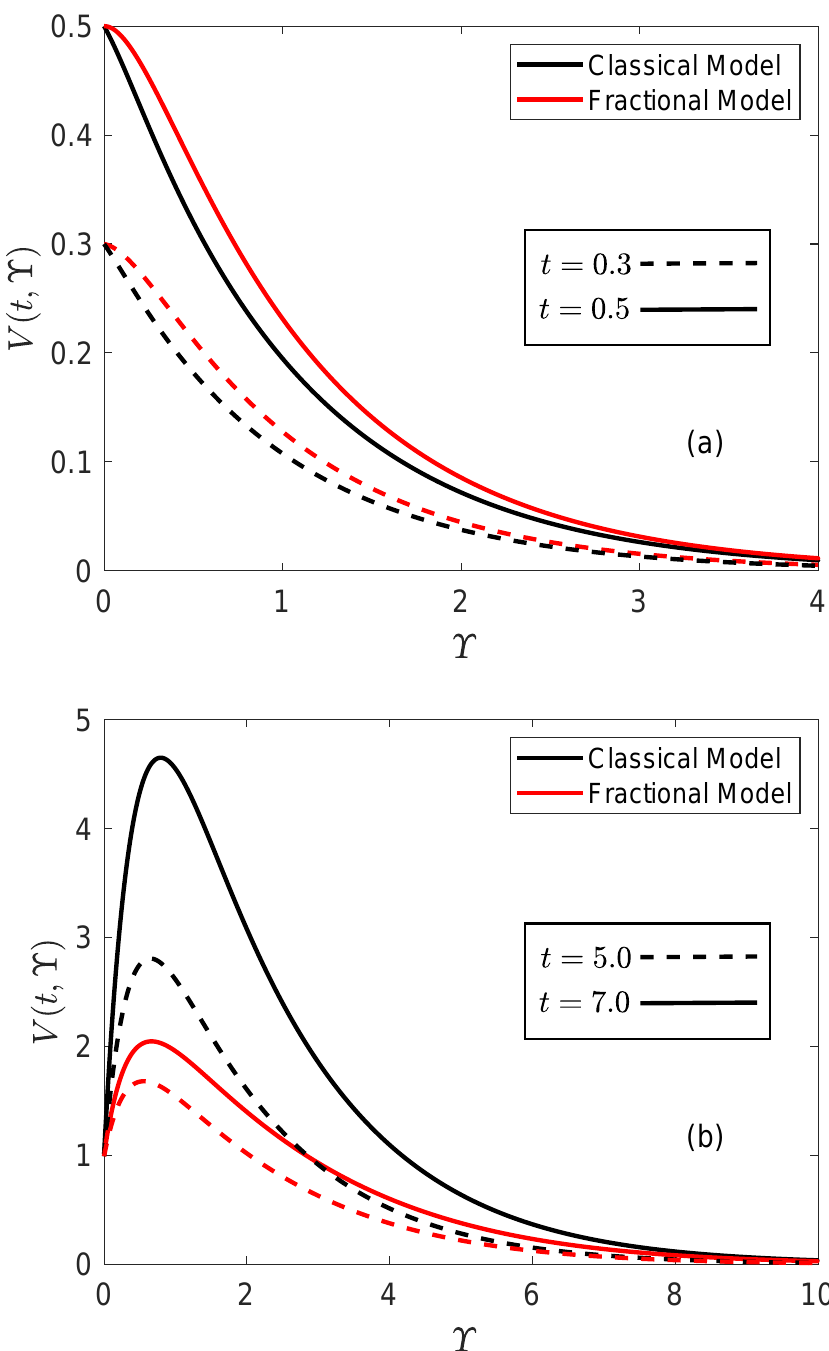
Figure 15. ( a ) Flow profile corresponding to fractional and classical cases for smaller time inputs. ( b ) Flow profile corresponding to fractional and classical cases for larger time